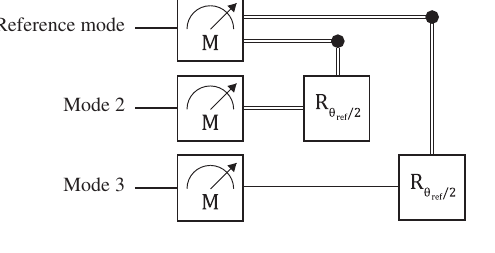
FIG. 6. A cartoon of the correlation feed-forward protocol for the three-mode trisqueezed state. This scheme tests our hypoth- esis on the conditional structure of two- and three-mode corre- lations. In the three-mode protocol shown here, we first measure the local phase of the reference mode (mode 1 in this example), = 2 on the other two modes. followed by applying a rotation by ϕ ref The result is an observable correlation between mode 2 and mode 3 with the characteristic structure of two-photon SPDC, i.e., two- mode squeezing. FIG. 7. The resultant single-mode histogram of mode 1 after applying the correlation feed-forward protocol to the two-mode trisqueezed state. We take mode 2 as the reference mode, correcting the phase of mode 1. Then, we compute the histogram of the data and subtract from it the histogram of the system noise (with the pump turned off) after also applying the protocol. We clearly see that the subtracted histogram is stretched along the x axis, indicating squeezing of the on state. The small rotation of the figure can be explained by a small misalignment of the pump and digitizer phases (see Fig.